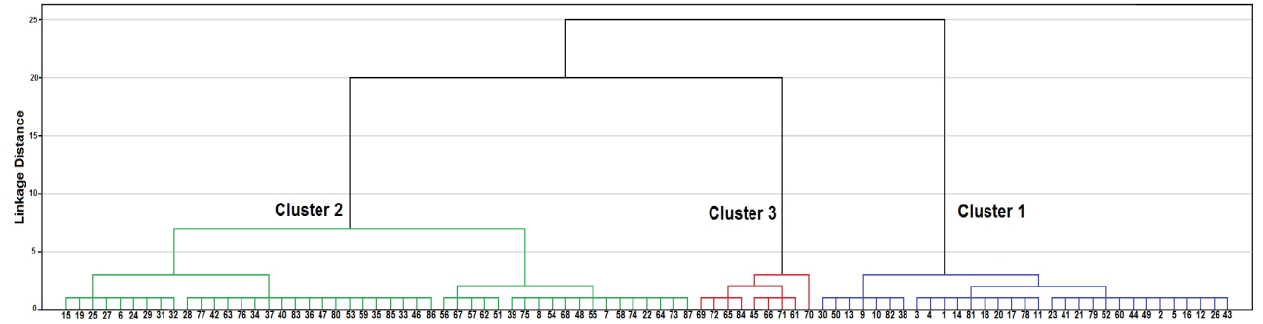
Figure 3. Dendrogram of Q-mode cluster. Table 1. Parameter’s value of the three principal water